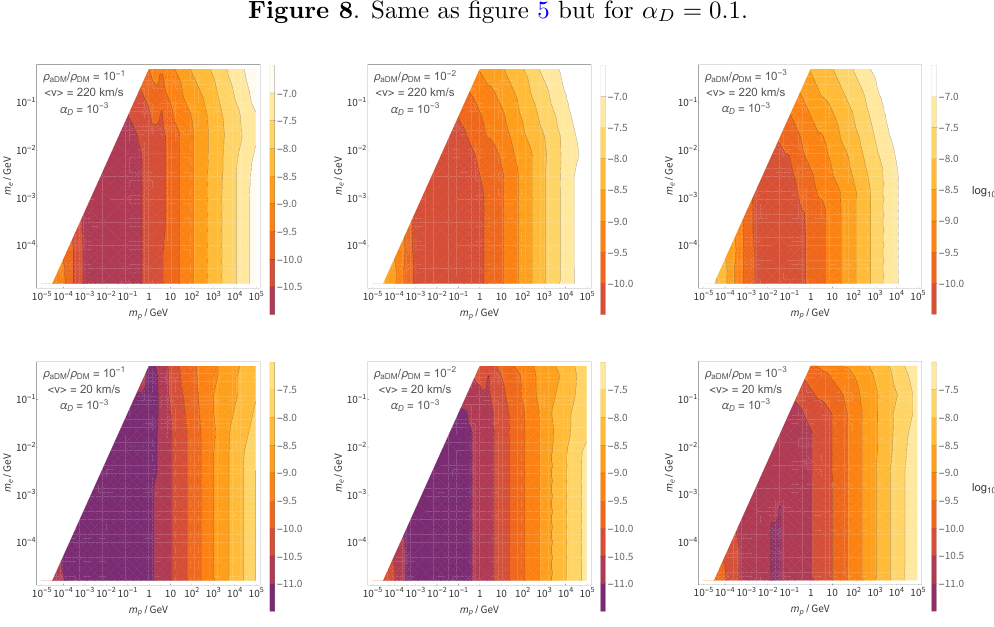
Figure 9 . Same as figure 5 but for α D = 10 − 3